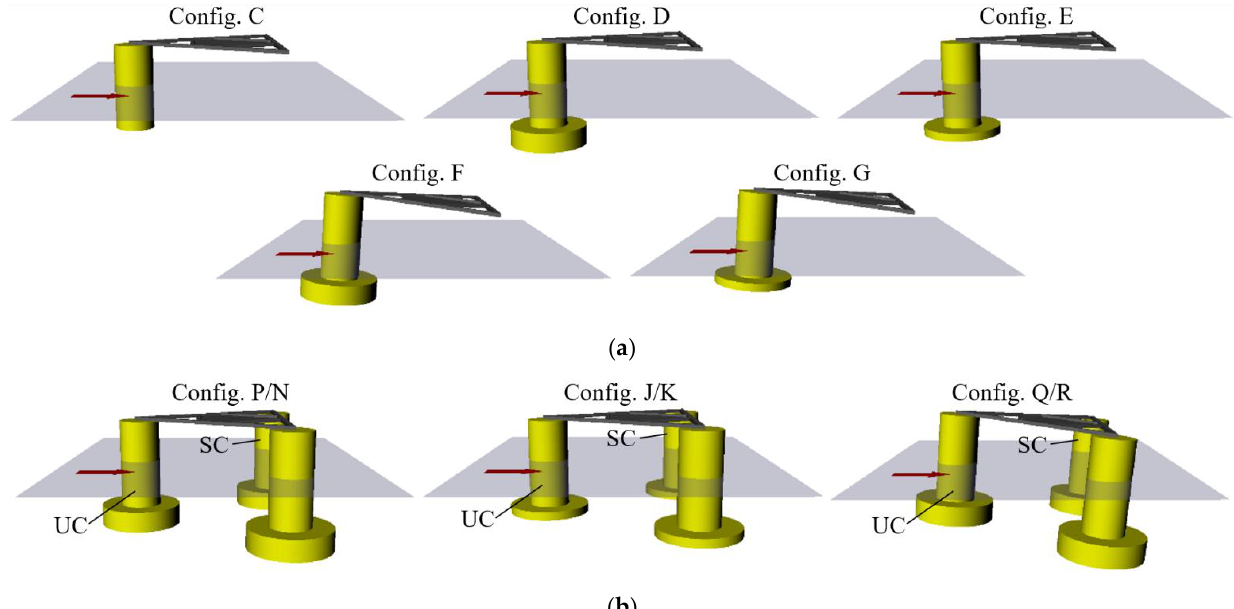
Figure 6. Configurations of the physical model included in the OC6 Phase Ib validation campaign. ( a ) Single-column configurations. ( b ) Three-column configurations with the upstream column (UC) and starboard column (SC) labeled. The arrows indicate the direction of the incident waves. In ( b ), configurations N, K, and R are geometrically identical to configurations P, J, and Q, respectively. The only difference is that the column/heave plate with the pressure sensors was located at the UC position with P, J, and Q and at the SC position with N, K, and R.